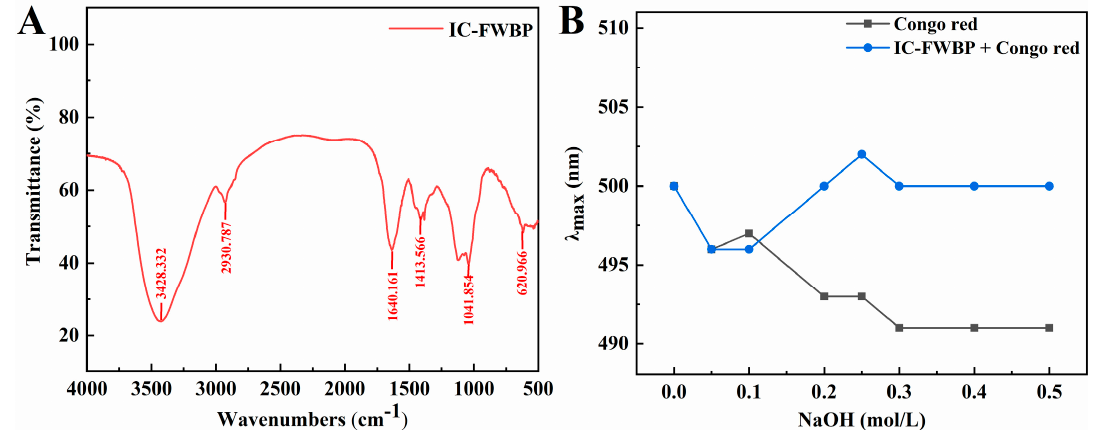
Figure 5. ( A ) FTIR spectral analysis and the triple-helix conformation analysis ( B ) of the IC-FWBP.